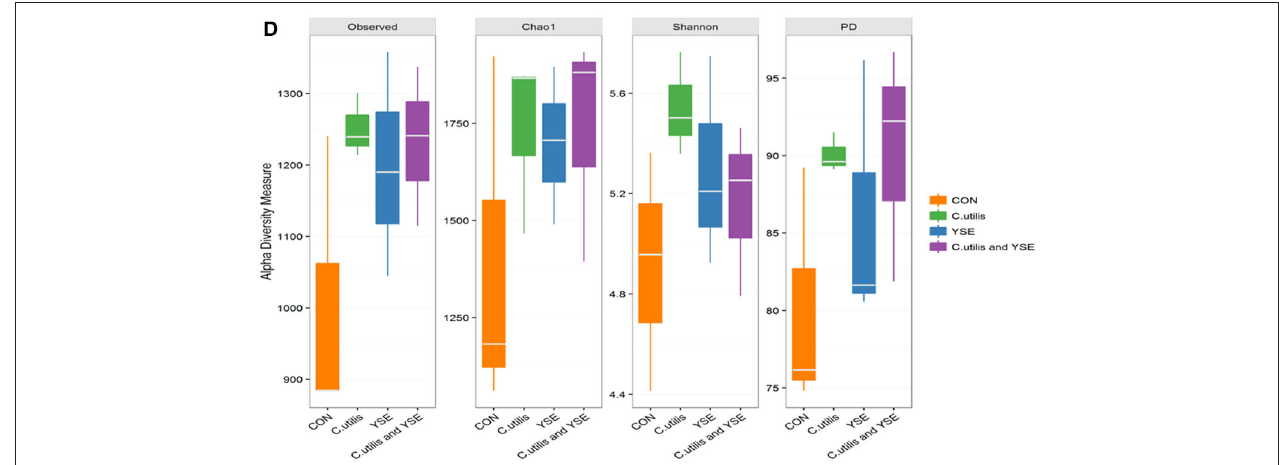
FIGURE 3 | Effects of dietary YSE and oral CU on cecal microflora of weaned piglet. (A) The Ven pot; (B) phylum barplot; (C) genus heatmap; (D) Alpha diversity analysis; piglets fed basal diet and orally administered 1mL of 0.85% saline (CON); piglets fed basal diet and orally administered 1mL 1 × 10 9 cfu/mL C. utilis in 0.85% saline ( C. utilis ); piglets fed the basal diet containing YSE (120 mg/kg) and orally administered 1mL of 0.85% saline (YSE); Piglets fed the basal diet containing 120 mg/kg YSE and 1mL 1 × 10 9 cfu/mL C. utilis in 0.85% saline ( C. utilis and